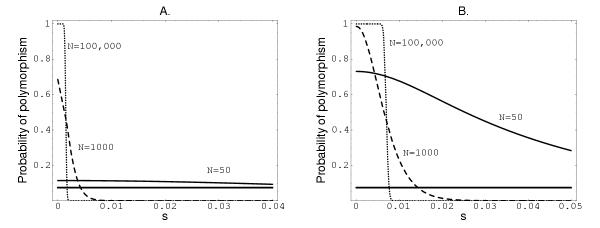
Probability of polymorphism as a function of s. Left: the detection threshold is set at 0.3; Right: the detection threshold is set at 0.1. The mutation rate is set to μ = 7.9 × 10-4